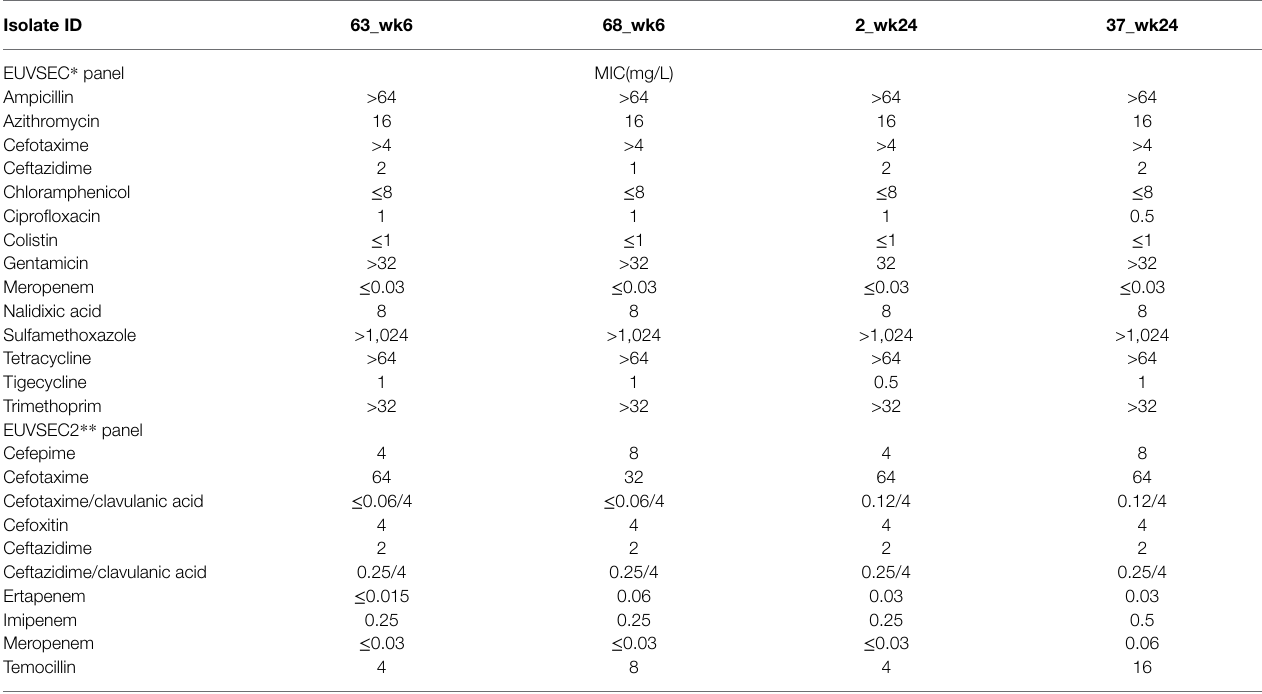
TABLE 2 | Antimicrobial susceptibility testing expressing the Minimal Inhibitory Concentration (MIC) determined in four Klebsiella pneumoniae isolates collected from calves in week 6 and week 24 at the veal farm. Isolate ID